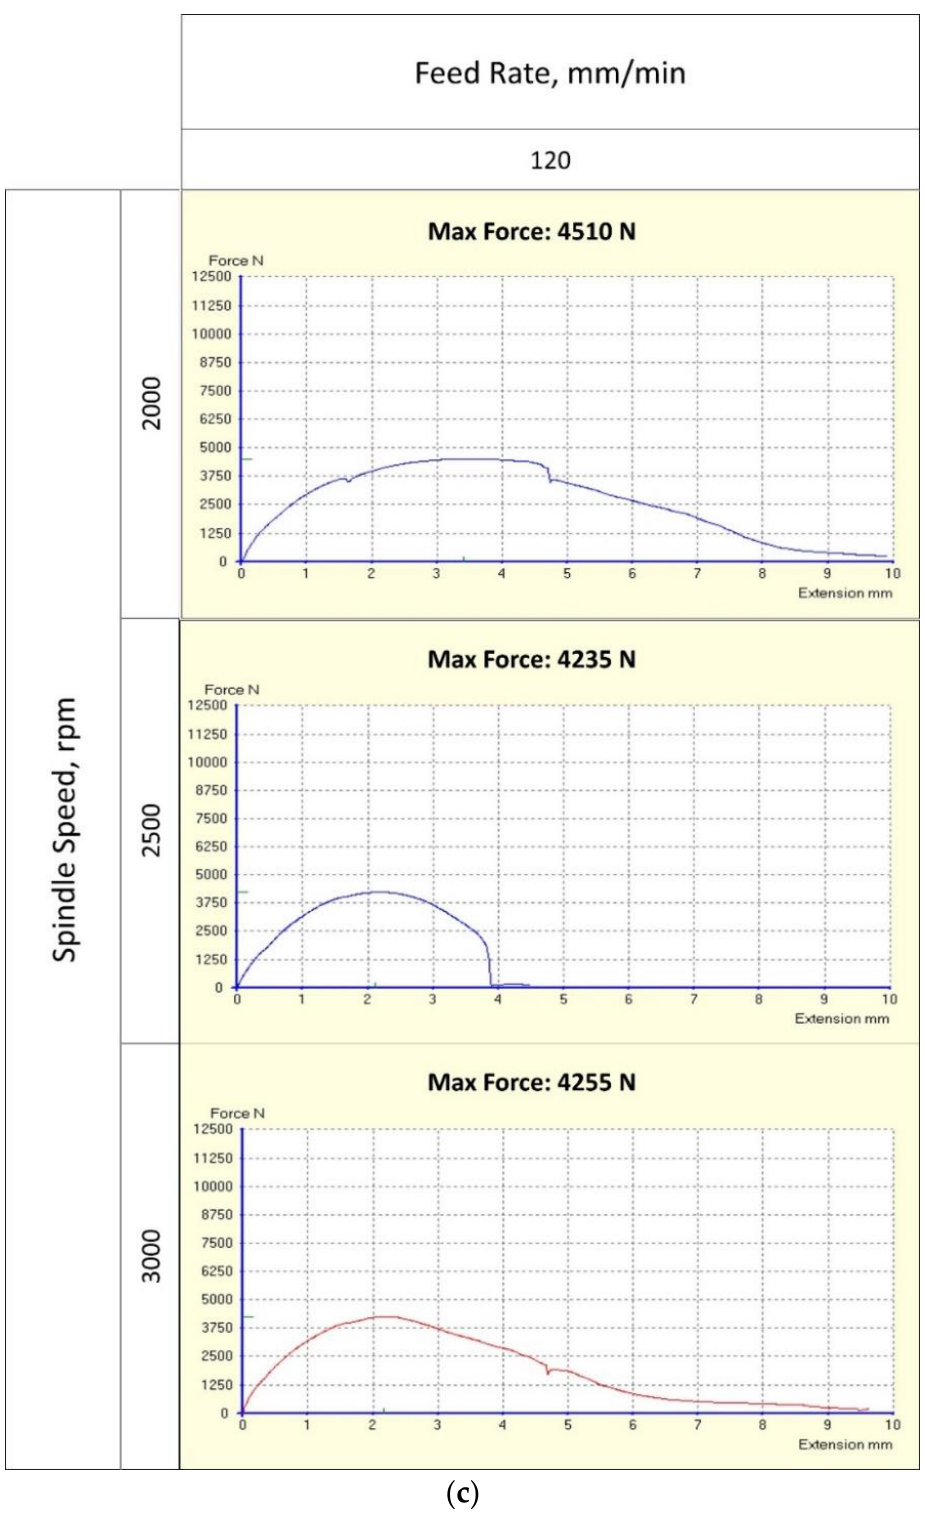
Figure 11. Tensile-shear strength test on formed joints under the normal condition with different spindle speeds and feed rates. ( a ) Tensile-shear test with feed rate 80 mm/min and spindle speeds 2000, 2500, and 3000 rpm. ( b ) Tensile-shear test with feed rate 100 mm/min and spindle speeds 2000, 2500, and 3000 rpm. ( c ) Tensile-shear test with feed rate 100 mm/min and spindle speeds 2000, 2500, and 3000 rpm.